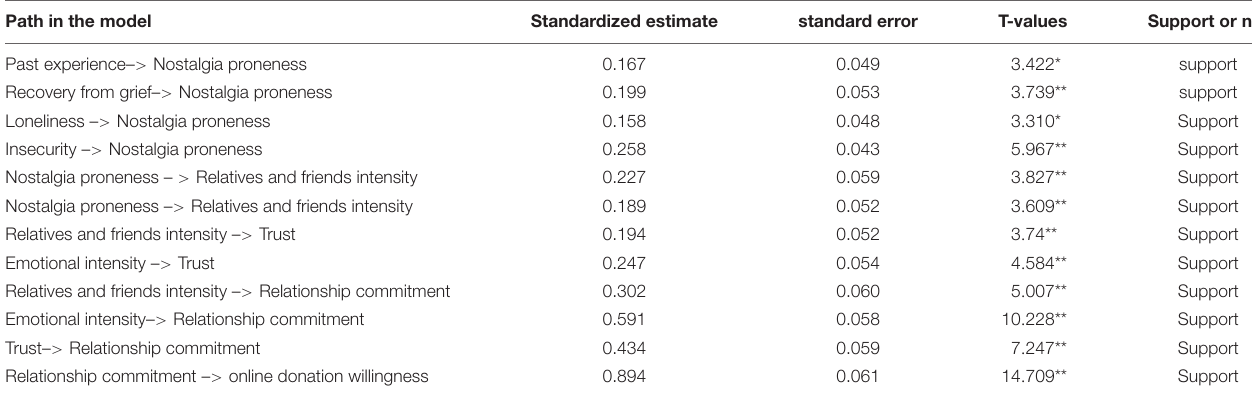
TABLE 4 | Structural model results and hypothesis